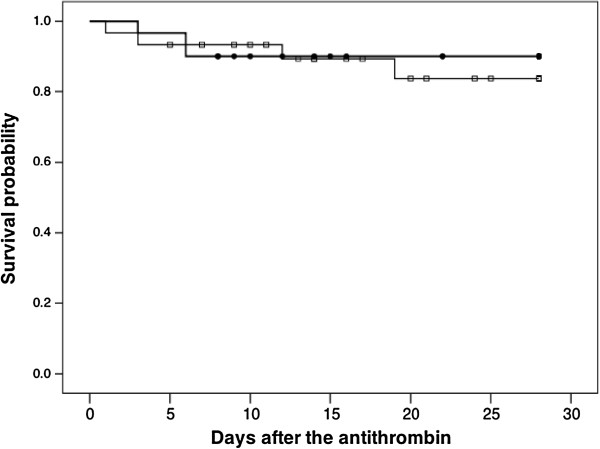
The Kaplan-Meier survival plots for the 30 patients in the control group (squares) and 30 patients treated with antithrombin (circles).